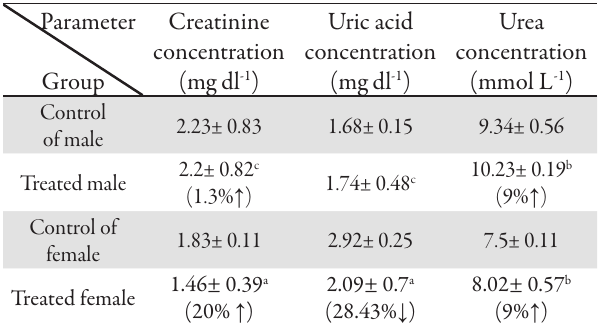
Tab. 4. Serum levels of kidney function parameters of rats administered aqueous alcoholic extract of Salvadora persica